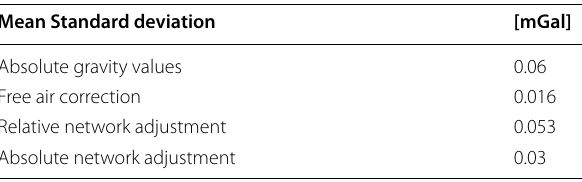
In general, we do not observe a systematic correla- tion between the final misfit and the elevation change between the original and the final projected surface point elevations during TAC, showing that the TAC